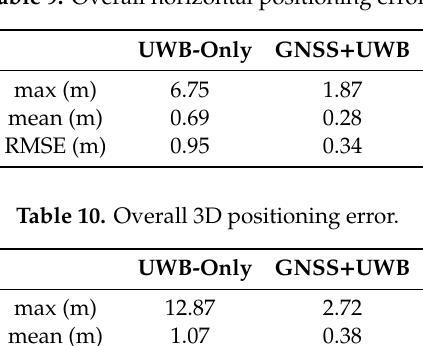
Table 9. Overall horizontal positioning error.